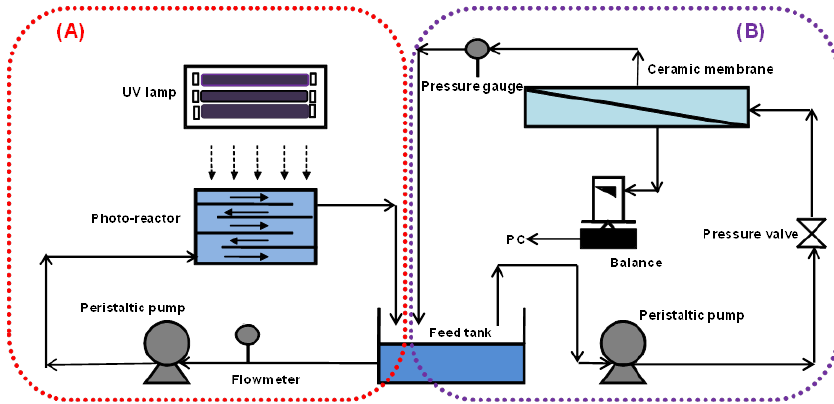
Figure 1. Schematic of a lab-scale photocatalysis/membrane system ( A ) Photocatalytic oxidation system and ( B ) Membrane system.